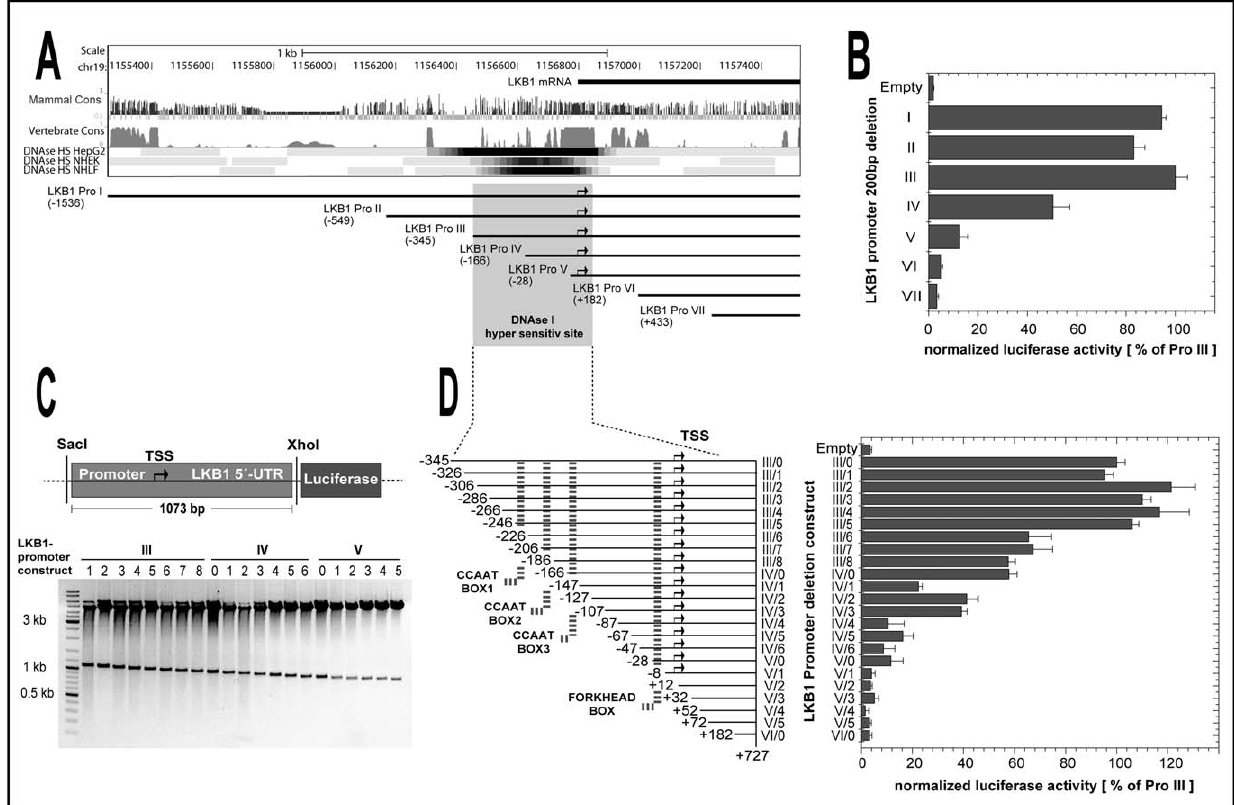
Figure 1. Deletion-mutant analysis of the LKB1 promoter. ( A ) Regions of high mammalian and vertebrate sequence conservation in the 5 9 - flanking region of the LKB1 coding sequence are aligned to DNase I hypersensitive sites (DNAse HS) in HepG2, normal human epidermal keratinocytes (NHEK) and normal human lung fibroblasts (NHLF) and to LKB1 200 bp deletion mutants (LKB1 Pro I–VII) extending from nucleotide position 2 1536 to + 727 relative to the transcription start site (modified from the UCSC genome browser at http://genome.ucsc.edu/ENCODE/). ( B ) Luciferase activity of transiently transfected ‘‘444’’ cells with 200 bp deletion constructs (I–VII) of the LKB1 promoter. ( C ) 20 bp deletion mutants of the LKB1 promoter Pro III fragment, starting from nucleotide 2 345 to + 727 (III–V) were constructed, digested by the restriction enzymes SacI and XhoI and separated in a 1% agarose gel. The transcriptional start site (TSS) as well as the 5 9 -untranslated region (5 9 -UTR) is indicated. ( D ) Comparison of luciferase activity of transiently transfected ‘‘444’’ cells with LKB1 promoter 20 bp deletion constructs (right) and predicted cis -regulatory elements (left). The positions of the potential CCAAT boxes I–III as well as the forkhead box are indicated. Luciferase activity of all deletion constructs (relative light units normalized against renilla luciferase activity) is expressed as the percentage of the signal obtained with the plasmid containing the LKB1 promoter region downstream of nucleotide 2 345 (LKB1 Pro III). All assays were performed three times in quadruplicate. The error bars denote mean 6 standard deviation.